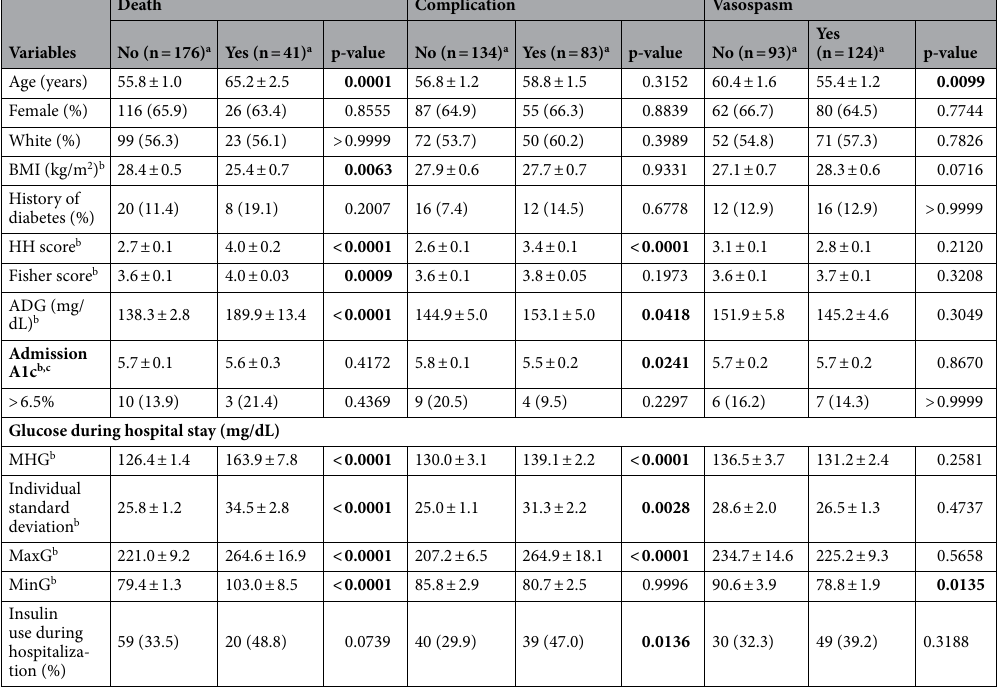
Table 3. Factors associated with higher mortality, complications, and vasospasm. Boldface values are statistically significant. a Values reported as mean ± SEM or count (%). b Non-normally distributed. c n = 87 patients.